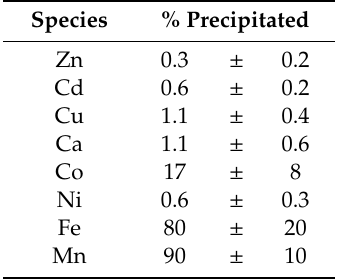
Figure 7. Precipitation of Fe and Mn with increasing the Eh while maintaining a pH of 3.0 ( a ) Fe, Mn, and Co contents in the solution during the oxidation to 1000 mV. ( b ) Fe and Mn contents in the solution during the oxidation below 1000 mV. Table 6. Metal precipitation during the oxidation for Fe-Mn removal of the leach solution (Average ( ± standard deviation) results of three (3) tests (Eh = 90 to 650 mV, pH = 3.0, 80 ◦ C, 15